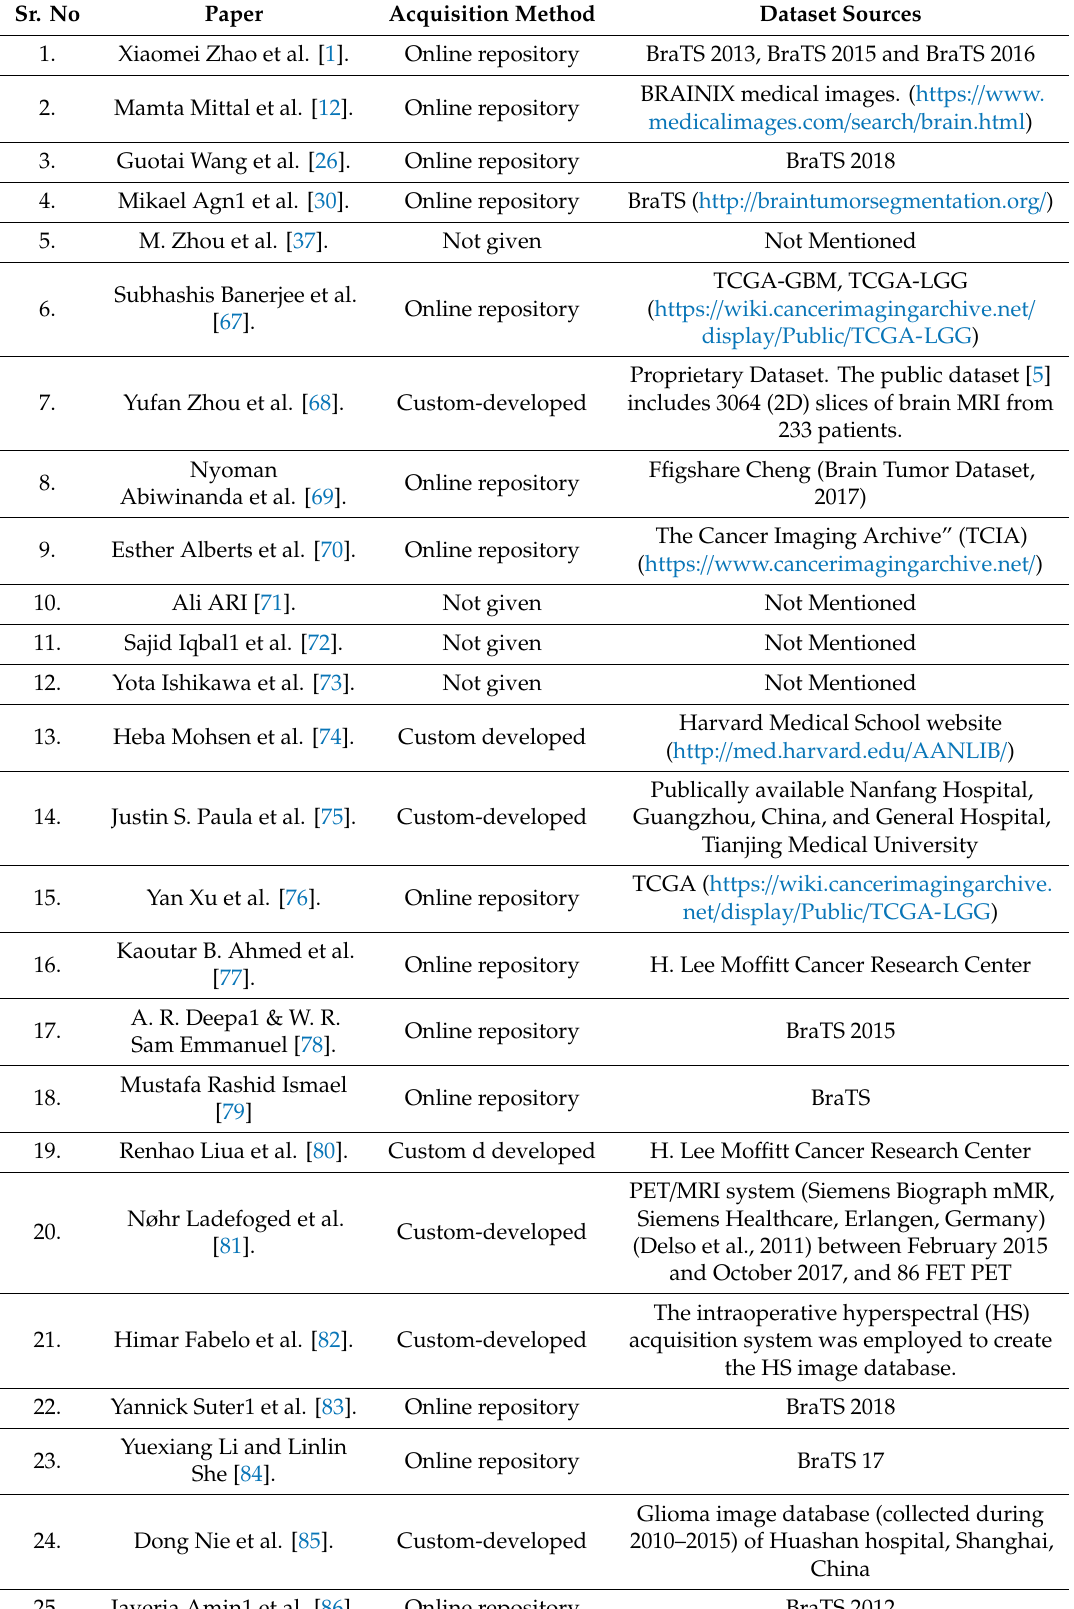
Table 1. Data sources and their acquisition